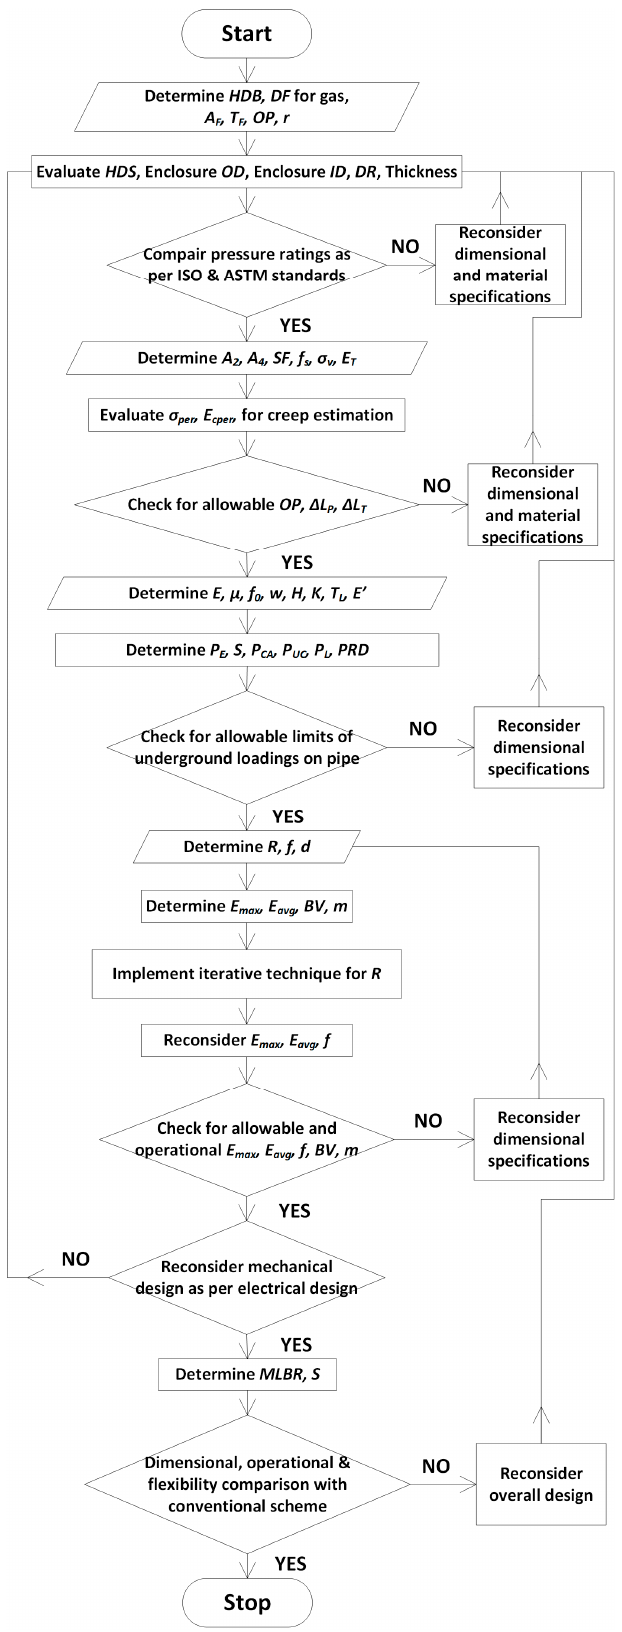
Figure 6. Flow chart of design algorithm for PE 100 based flexible-thermoplastic-enclosure of FGIL.